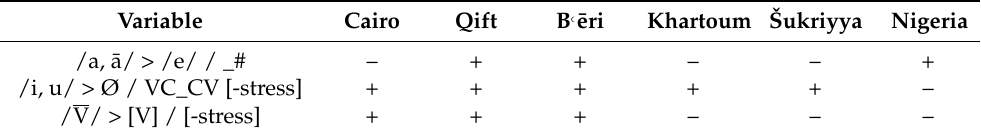
Table 2. Phonological